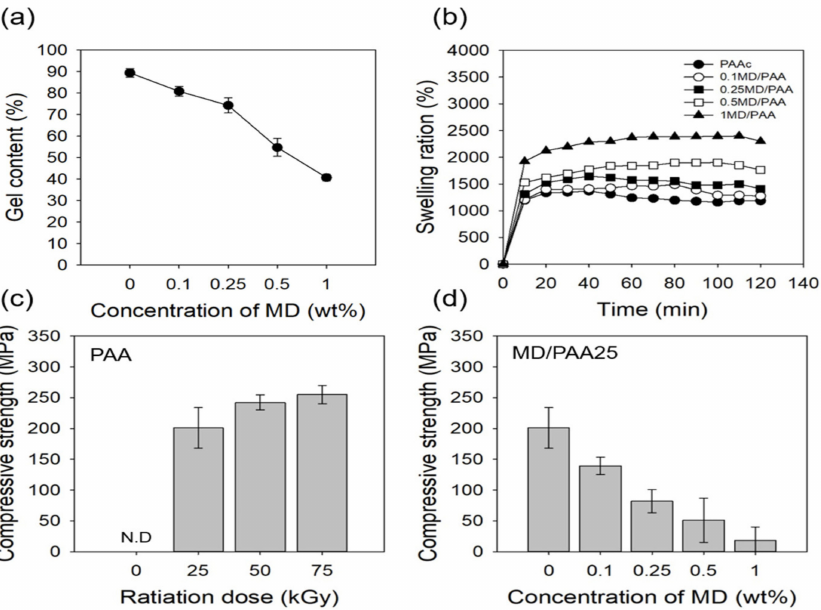
Figure 8. ( a ) Gel content of MD / PAA hydrogel films with di ff erent content of MD from 0 to 1 wt% with radiation dose at 25 kGy, ( b ) degree of swelling of MD / PAA hydrogel films with di ff erent content of MD from 0 to 1 wt% with radiation dose at 25 kGy, ( c ) Compressive strength of 7 wt% PAA hydrogel films with di ff erent radiation dose of 0, 25, 50, or 75 kGy, and ( d ) MD / PAA hydrogel films with di ff erent MD content (0, 0.1, 0.25, 0.5, or 1 wt%) with radiation dose at 25 kGy. (N.D = not